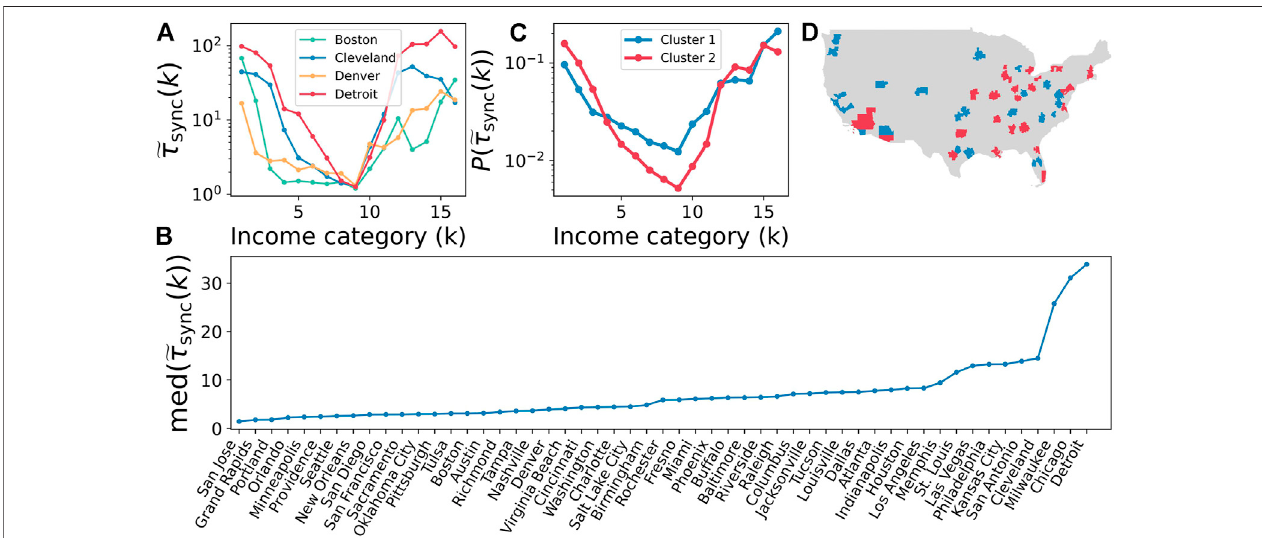
FIGURE3| Synchronizationtimeasameasureforincomesegregation. (A) Synchronizationtimeforeachofthe16incomecategoriesinBoston,Cleveland,Denver and Detroit. (B) Ranking for the median value of ~ τ sync ( k ) for the studied set of US cities. (C) Average value of P ( ~ τ sync ( k )) as a function of each income category i for the two main clusters detected. (D) Location and cluster assignment for each of the analyzed